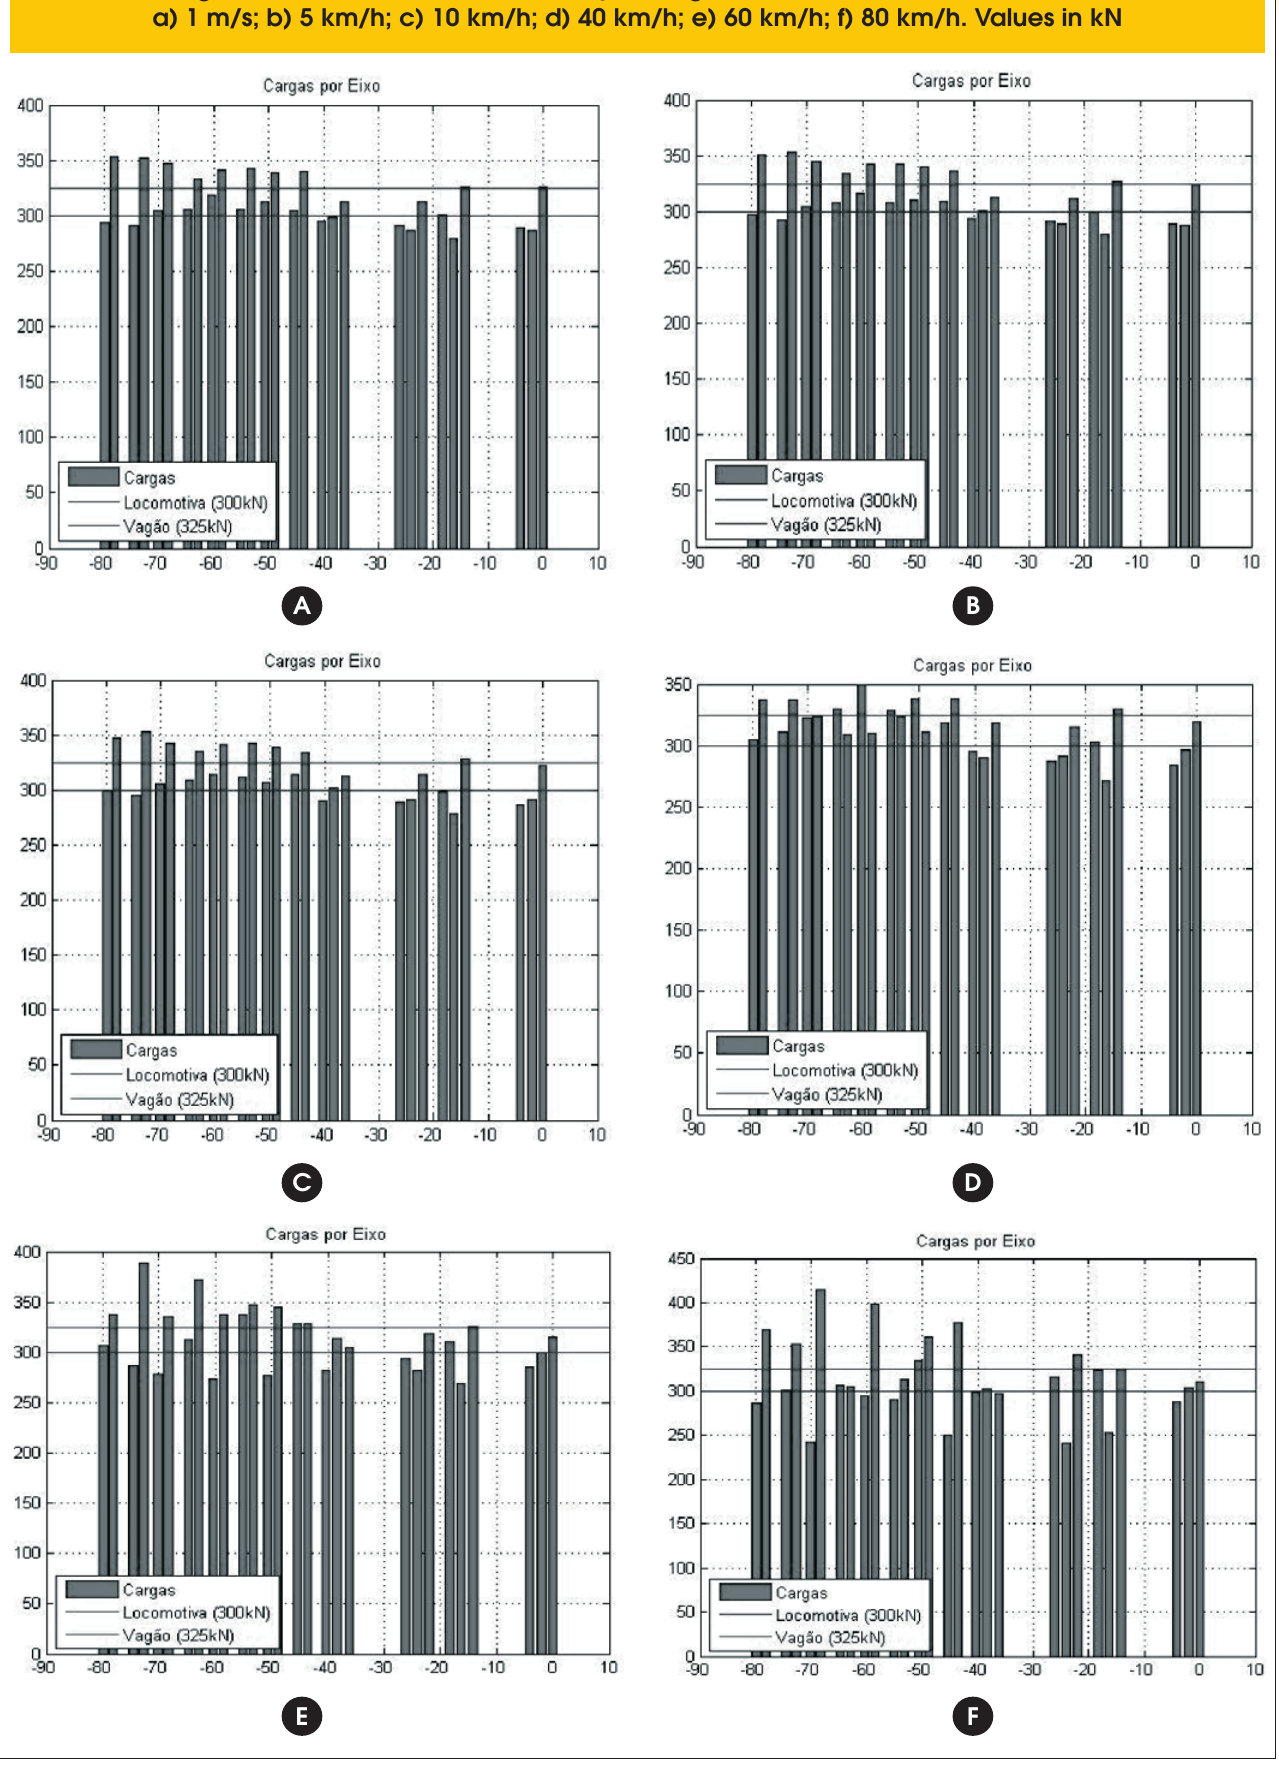
Figure 9 – Axle loads determined by the algorithm of Moses [1] for